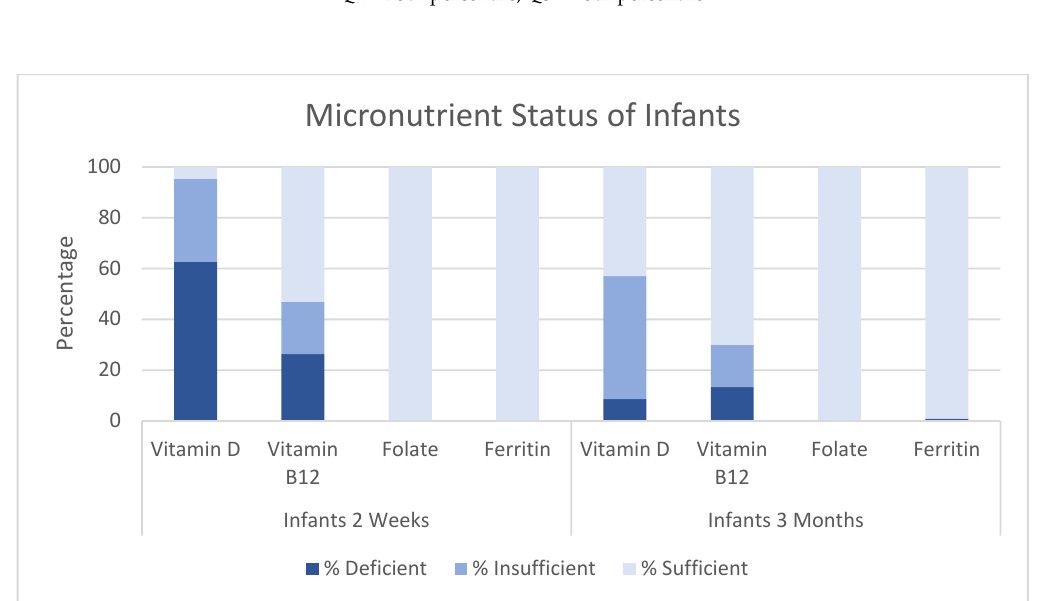
Figure 1. Micronutrient status of infants two weeks and three months of age. Y-axis indicates percentage. X-axis indicates micronutrient.